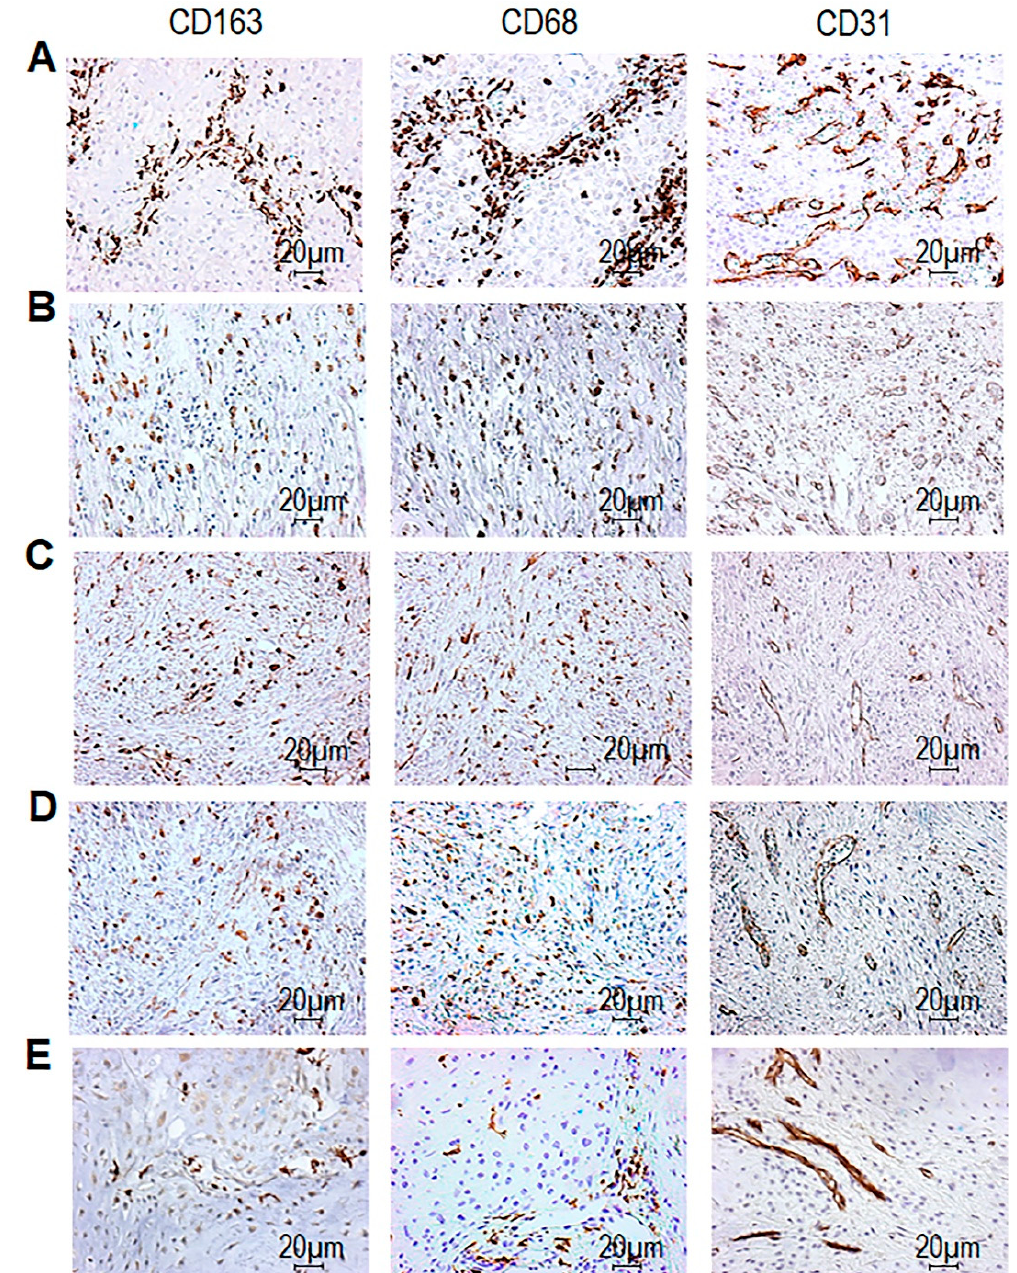
Figure 1. CD68, CD163, and CD31 expression in tumor tissues from chondrosarcomas (CHS) patients. CHS tissues were processed for IHC analysis of CD68 + and CD163 + cells, and CD31 + microvessels. Sections were scored based on the average counts of positive cells (CD68 and CD163) or microvessels (CD31) counted in the tumor areas, in five randomly selected fields / sample at 200 × magnification. For each section, positive cells or microvessels were scored as 1-5 where 1 (1–25), 2 (26–50), 3 (51–100), 4 (101–150), and 5 ( > 150) positive cells or microvessels were encountered in the field. Representative images of CD163 score 5 ( A , from patient #8) score 4 ( B , from patient # 16 ) score 3 ( C , from patient #14) score 2 ( D , from patient #13) and score 1 ( E , from patient #10). The corresponding CD68 and CD31 immunostaining are shown in the central and right columns (scoring is reported in the Table 2). Original magnification: 200×. Distribution of CD68, CD163 and i intratumoral microvessel density (iMVD) scores are reported in Table 2 and summarized in Figure 2A.